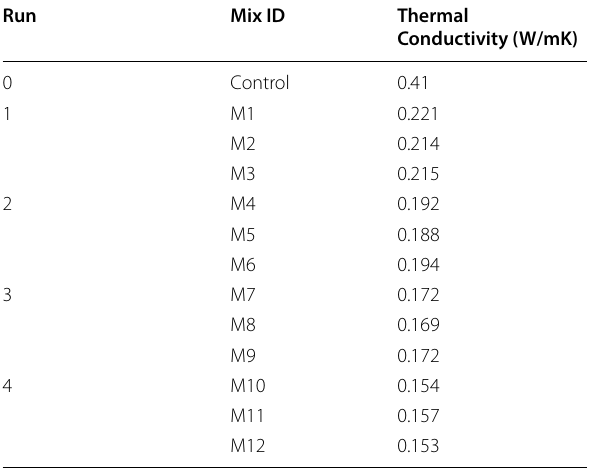
Table 9 Thermal conductivity results